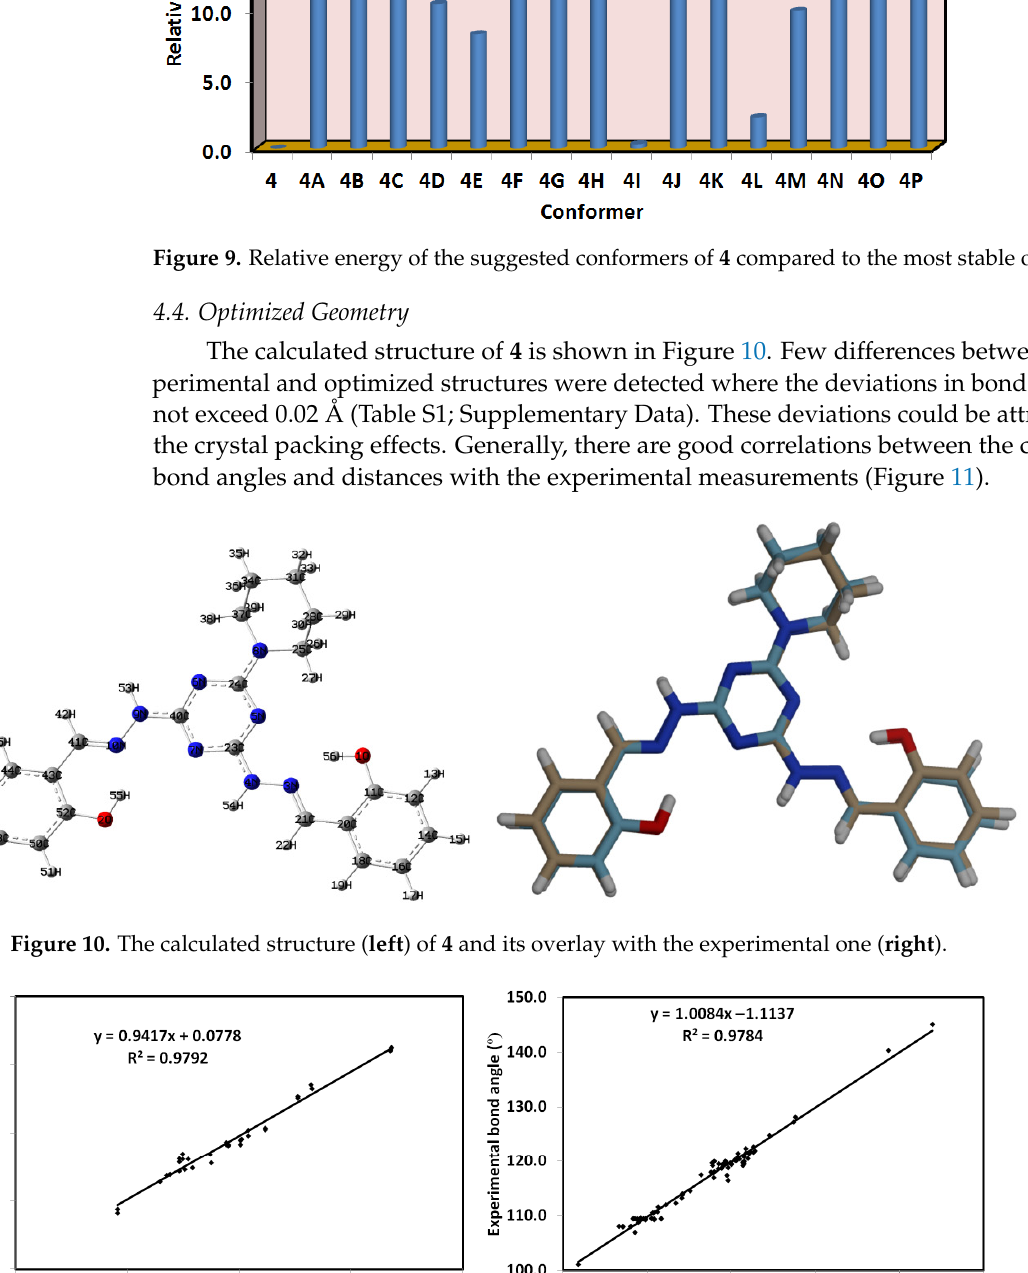
Figure 11. Correlations between the calculated and experimental geometric parameters.